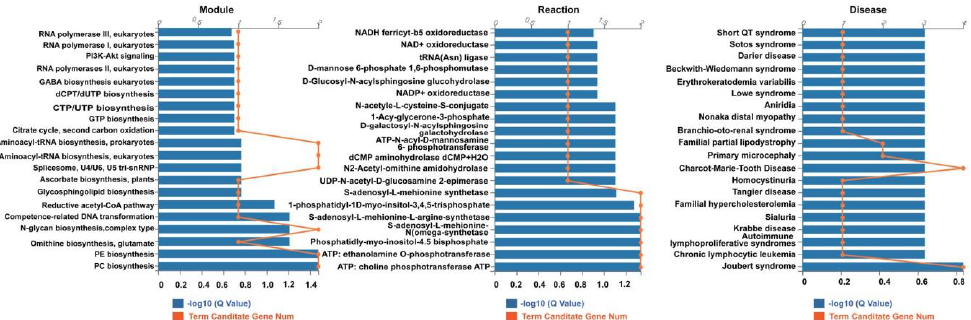
Figure 9. The Kyoto Encyclopedia of Genes and Genomes ( KEGG) pathway aggregation for the target genes of the 12 stably enriched DEmiRs. The result indicated that these target genes were involved in “aminoacyl-RNA biosynthesis in prokaryotes and eukaryotes, spliceosome, U4 / U6, U5 tri-snRNP, N-glycan biosynthesis, complex type, phosphatidylethanolamine (PE) biosynthesis, and phosphatidylcholine (PC) biosynthesis (Q = 0.03) in module group; “ S -adenosyl- l -methionine,